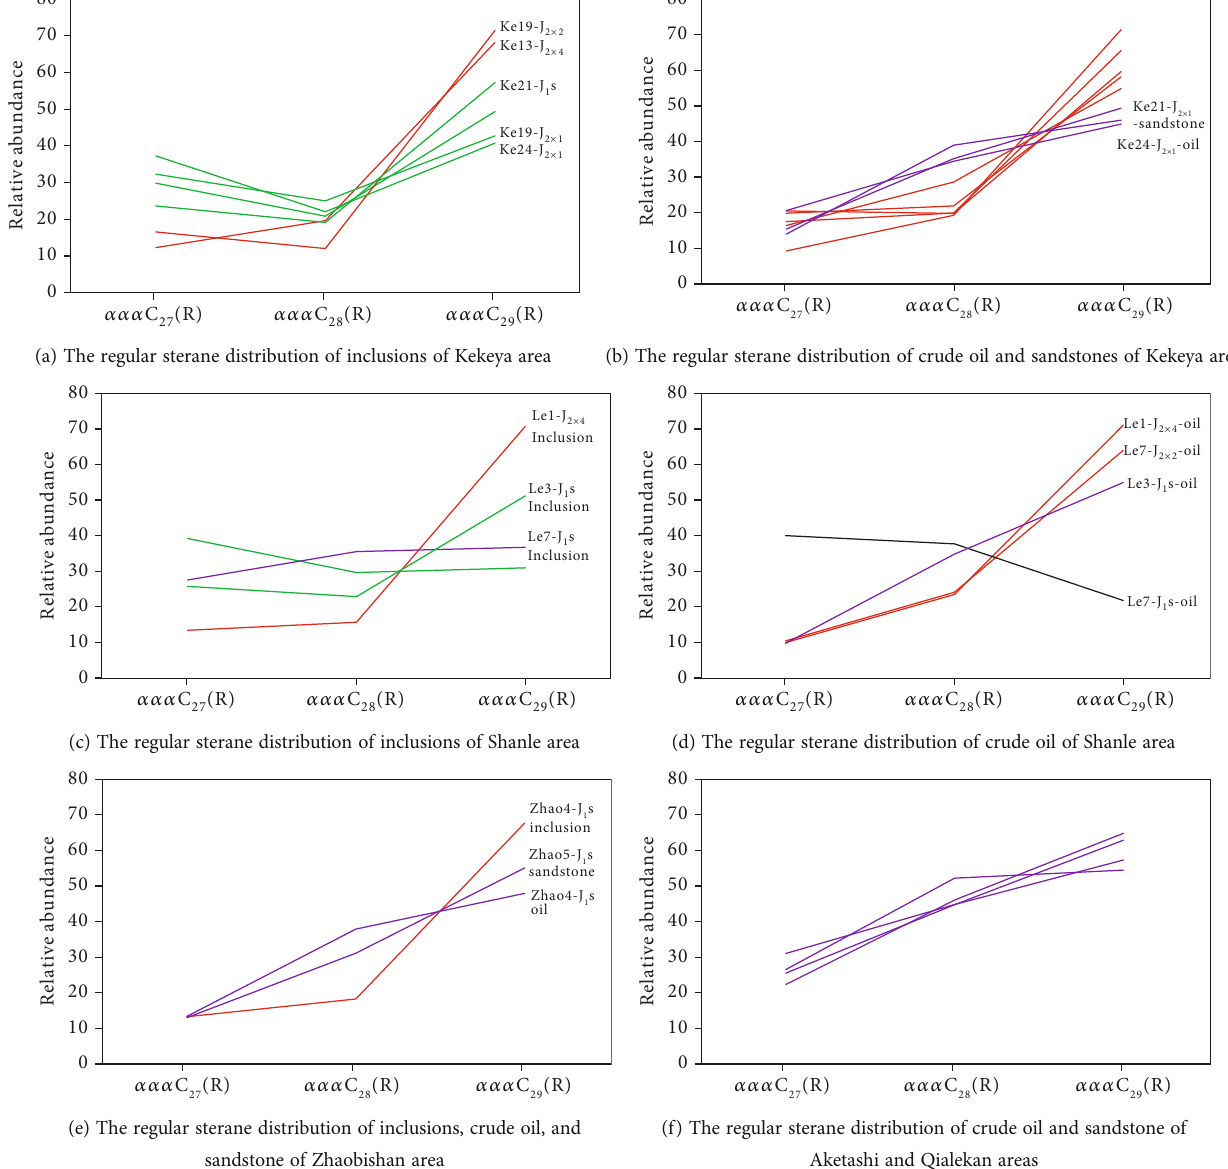
Figure 9: The regular sterane distribution of inclusions, crude oil, and sandstone of the northern piedmont belt. Note: See Table 1 for the data of each sample; red lines represent horizontally inverted L-shaped; green lines represent asymmetric V-shaped or symmetric V-shaped; purple lines represent vertically inverted